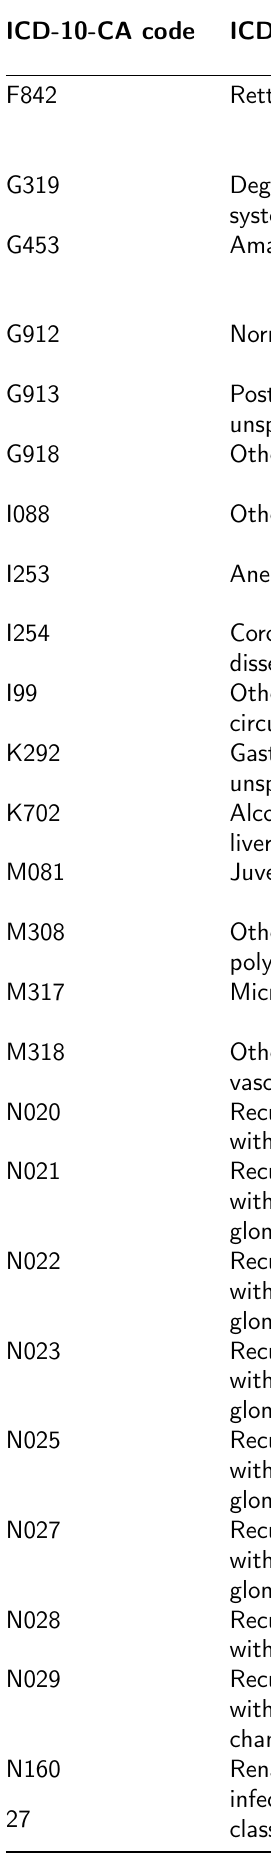
Supplementary Appendix 5: Discrepancies in ICD-10-CA mappings between the two